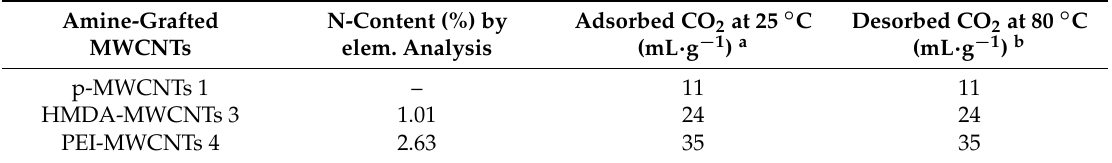
Table 2. CO 2 adsorption/desorption ability of amine-grafted MWCNTs.